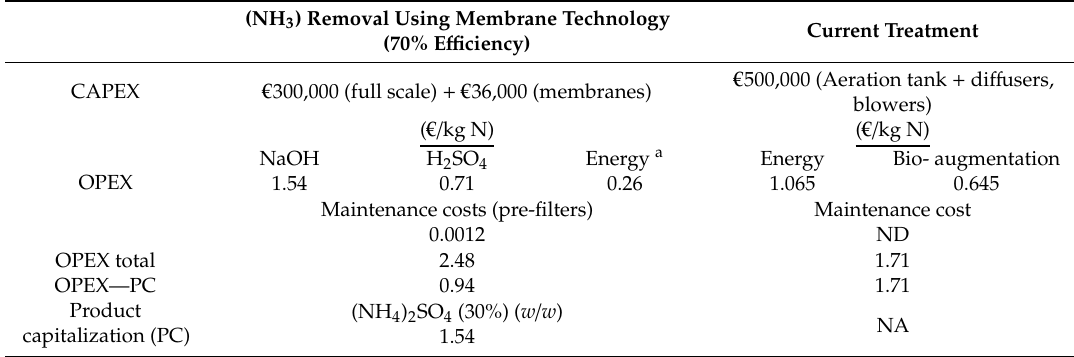
Table 6. Summary of cost benefit analysis ( a 0.009 € kWh − 1 – was used to estimate the cost. The energy Table 7. Summary of the specifications for the membrane modules tested. usage ( € / kg N) was calculated from the total ammonia removed / year and total blower energy use / year (data obtained from 2016 plant site)).